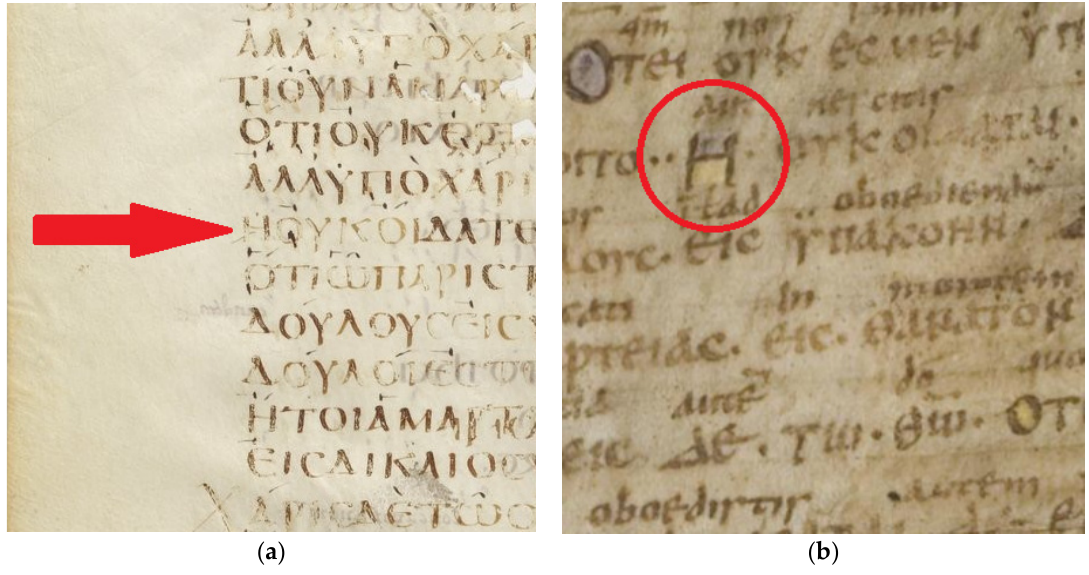
Figure 1. Two examples of Western text-type manuscripts interpolating the disjunctive eta to enhance Paul’s incredulity in Romans 6.15-16. ( a ) Detail of Codex Claromontanus (D p /Unical 06), fifth/sixth century, Folio 32, verso. Paris, Bibliothèque nationale de France. Available online: https://gallica.bnf.fr/ark:/12148/btv1b84683111/f70.item (Public Domain Mark 1.0; accessed on 5 March 2022). ( b ) Detail of Codex Boernerianus (G p /Unical 012), ninth century, Folio 9, recto. Dresden,